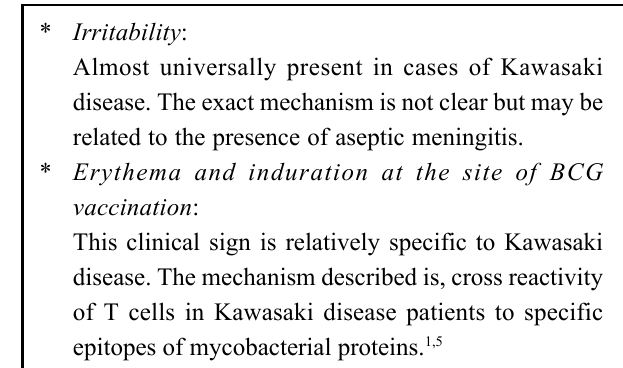
Table II : Important signs, not included in the